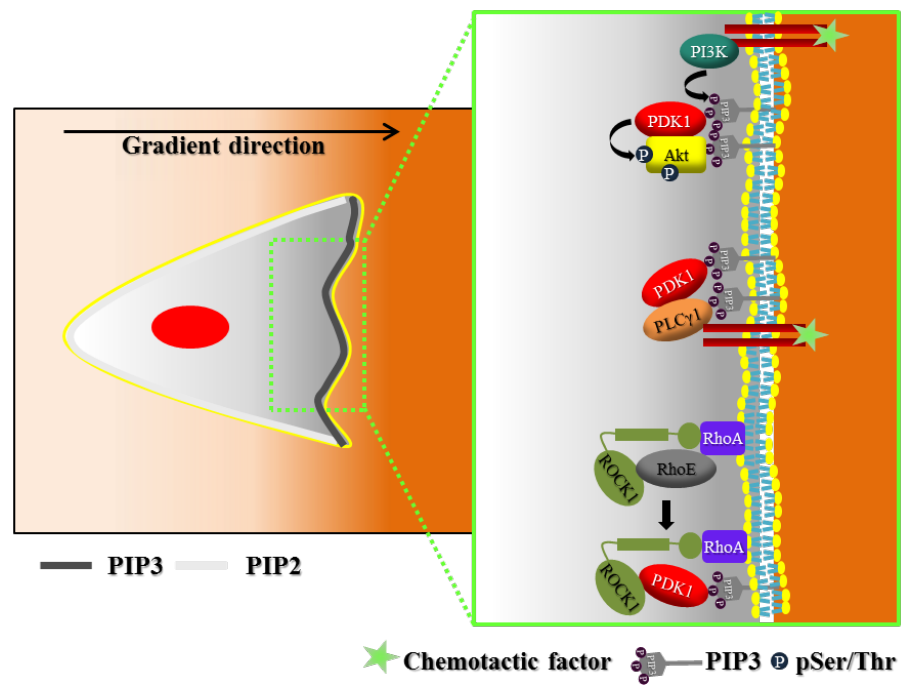
Figure 2. PDK1 contributes to polarization of signaling downstream to PI3K during cell migration. In the presence of a gradient of chemoattractant, a migrating cell is able to polarize following the direction of the gradient. This polarization is achieved by the localized activation of signaling proteins either at the front or at the rear of the cell. The PI3K pathway is activated at the leading edge of migrating cells, with the consequent accumulation of PIP3 (dark grey line). Conversely, while PI3K is excluded from the sides and the back of moving cells, the phosphatase PTEN specifically localizes to such portions of the cell, causing the accumulation of PIP2 (light grey line). The green box shows a detail of signaling activated by PDK1 at the leading edge, downstream to PI3K. First, PDK1 phosphorylates and activates Akt at front of migrating cells. Moreover, through a kinase-independent mechanism, PDK1 is able to stimulate function of phospholipase C gamma 1 (PLCγ1) and ROCK1.